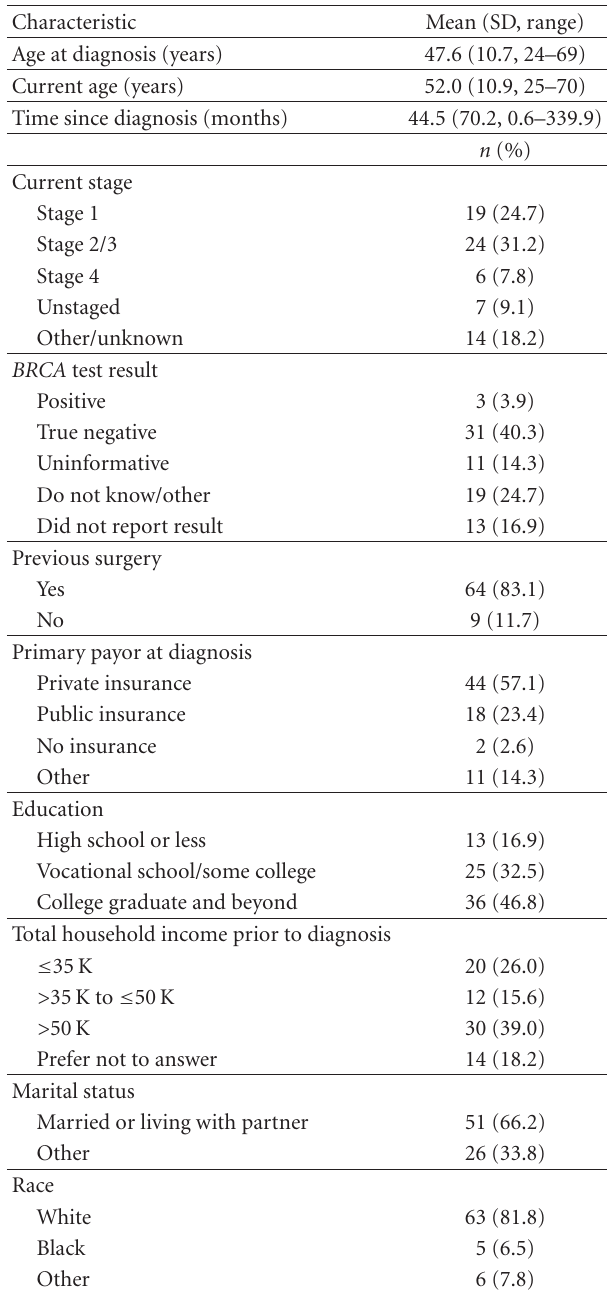
Table 1: Sociodemographic and clinical characteristics of study participants who had BRCA testing ( n = 77) a .